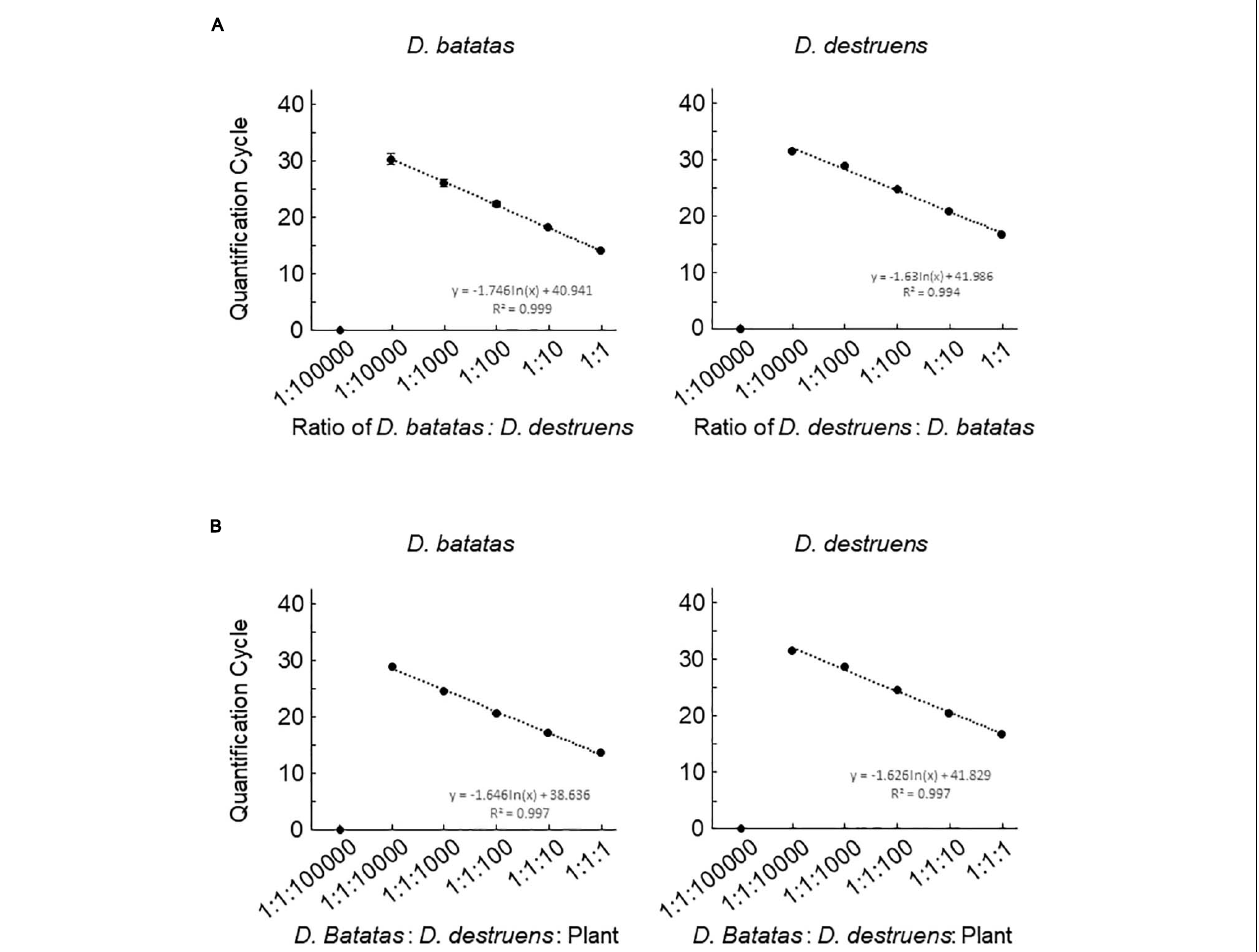
FIGURE 3 | Detection efficiencies of the assay for Diaporthe batatas and Diaporthe destruens DNA in a simulated co-infection. Coinfection was simulated using mixtures of template DNA at various ratios. (A) mixtures of D. batatas and D. destruens DNA and (B) mixtures of fungal DNA and background sweet potato DNA. In the left panel of (A) , D. destruens DNA (5 ng µ L − 1 ) was mixed with a 10-fold dilution series of D. batatas DNA (5, 0.5, 0.05, 0.005, 0.0005, and 0.00005 ng DNA µ L − 1 ), providing ratios of D. batatas to D. destruens DNA in the range of 1:1 to 1:100000. In the right panel of (A) D. batatas and D. destruens were exchanged and tested at the same DNA mixing ratios. In (B) , ratios of D. batatas : D. destruens : sweet potato DNA from 1:1:1 to 1:1:100000 were prepared by decreasing the concentrations of D. batatas and D. destruens DNA (5 to 0.0005 ng µ L − 1 ) while increasing the sweet potato DNA concentration (5 to 50 ng µ L − 1 ). The DNA concentrations in each reaction were 5:5:5, 5:5:50, 0.5:0.5:50, 0.05:0.05:50, 0.005:0.005:50, and 0.0005:0.0005:50 ng µ L − 1 . Three biological replicates of each dilution were prepared. The regression equations and R 2 coefficient of determination for Cq value versus the natural logarithm of the ratio of the various DNA indicated are shown on the charts. Data represent means ± standard deviation where